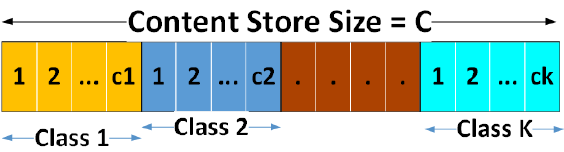
Figure 4. Illustration of K number of class partitions on the content